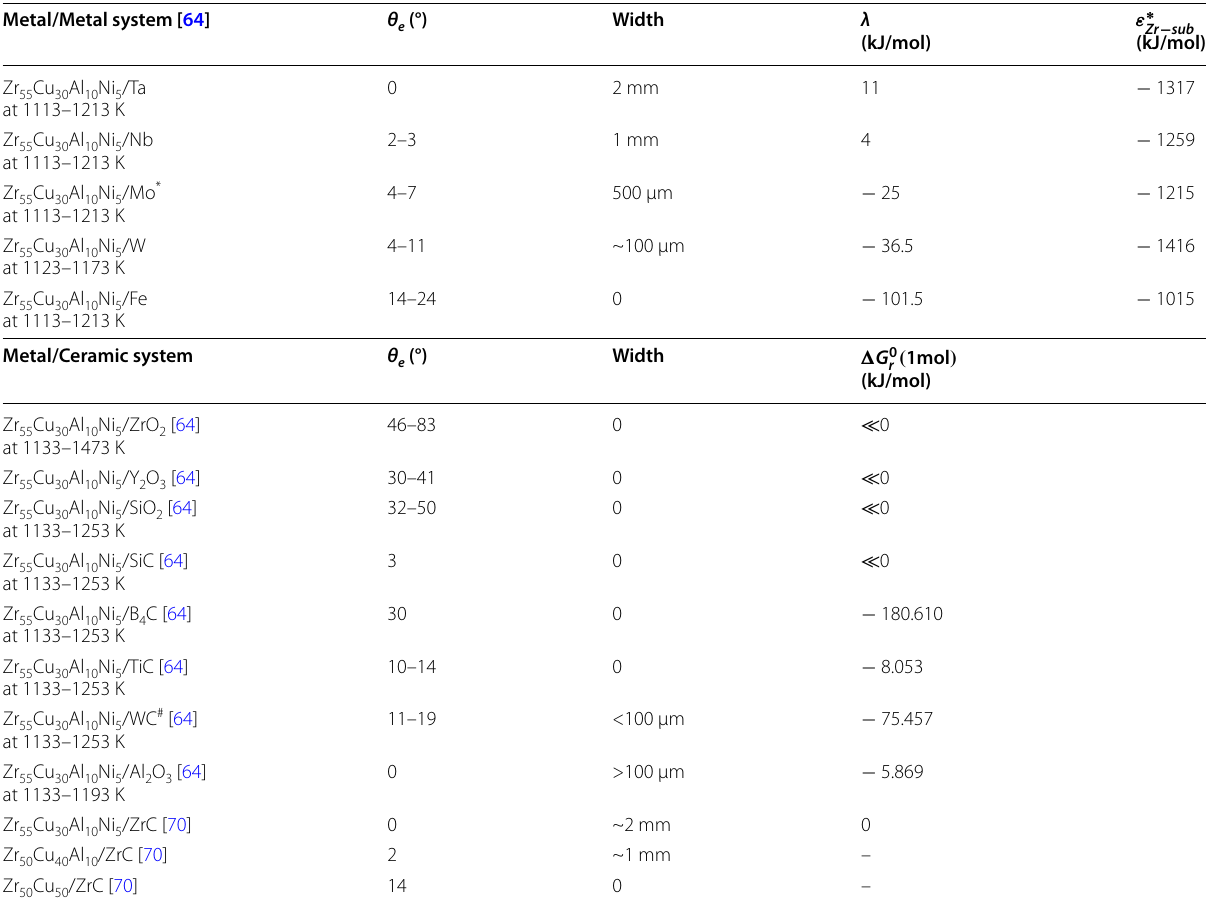
*PF appearance only at an experimental temperature of 1113 K; # PF above the ZrC reaction layer